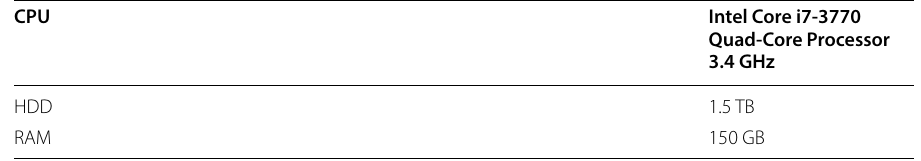
Table 14 Nodes for FiDoop and Sequence-Growth